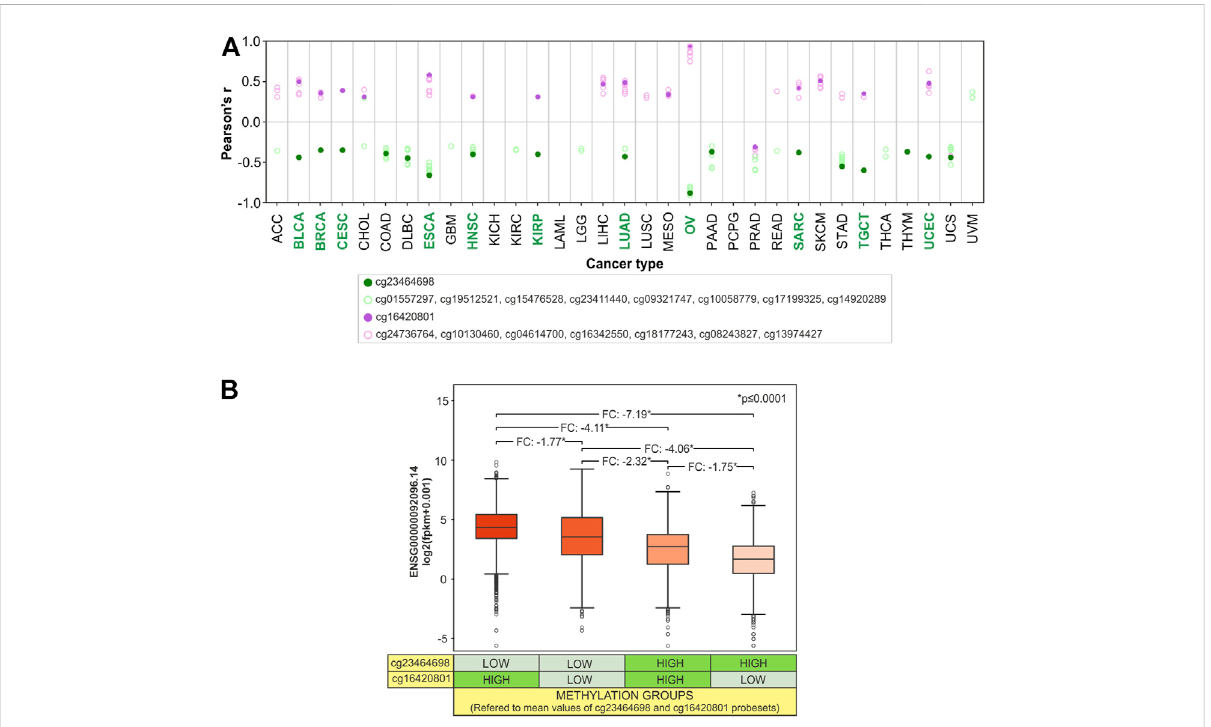
FIGURE 13 Synergic effect of promoter hypomethylation and body hypermethylation in the upregulation of SLC22A17 . (A) Correlation analysis between gene expression (ENSG00000092096.14) and CGprobesets methylation levels of SLC22A17 was evaluated for each tumor type. OnlyCGprobesets showingPearson ’ sr ≥ 0.3(magenta circles)andr ≤ − 0.3(greencircles) p ( ≤ 0.05)areincluded. Magentadotsindicatethecg16420801 probesetwhile green dots represent the cg23464698 probeset. Green label indicates tumor types in which both CG probesets are signi fi cantly correlated. (B) Differential analysis (two-tailed unpaired t -test) of SLC22A17 (ENSG00000092096.14) expression was performed stratifying the tumor samples in differentfourgroupsbasedonthemethylationlevelsofcg16420801 andcg23464698probesets withrespectto themeanvaluecalculatedfor each CG probeset in all tumor samples. FC and pValue are reported for each comparing